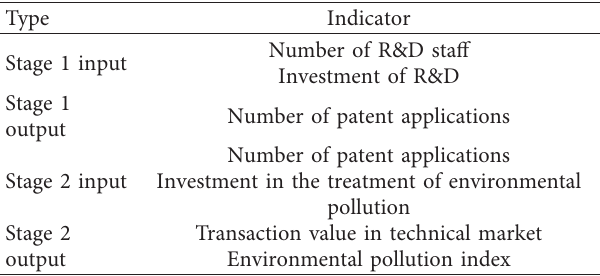
Table 1: Two-stage green innovation efficiency evaluation index